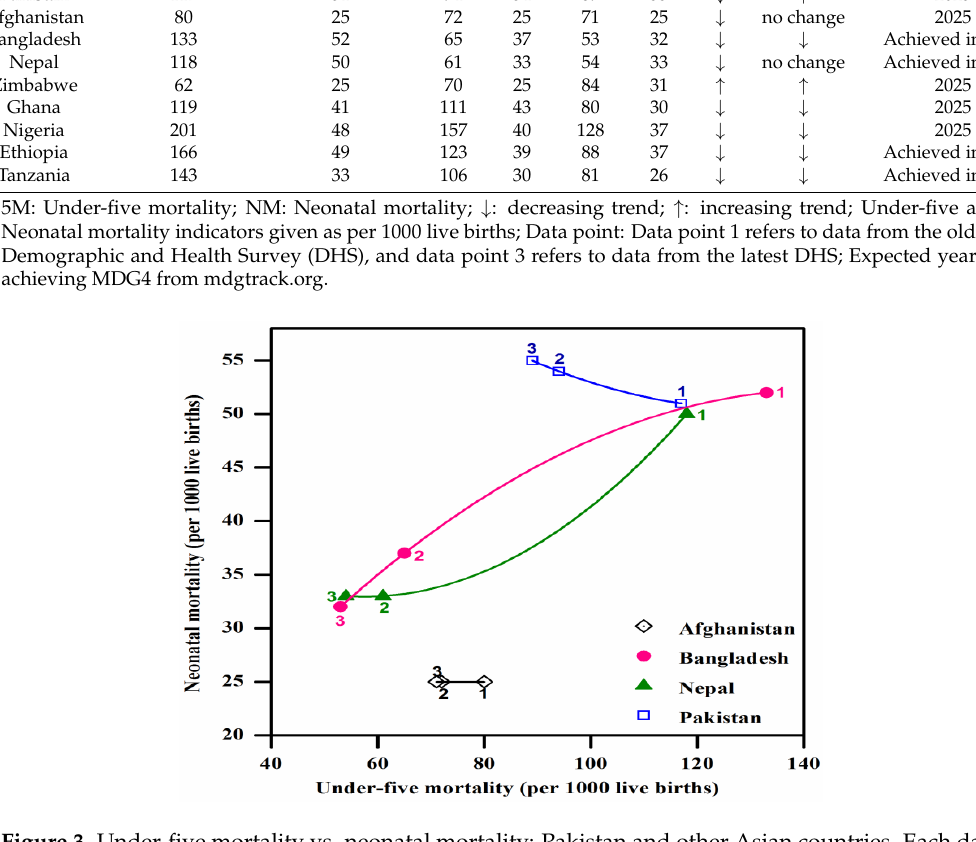
Figure 3. Under-five mortality vs. neonatal mortality: Pakistan and other Asian countries. Each data point is labelled 1, 2, and 3 for each country, where 1 and 3 denote the earliest and latest DHS,